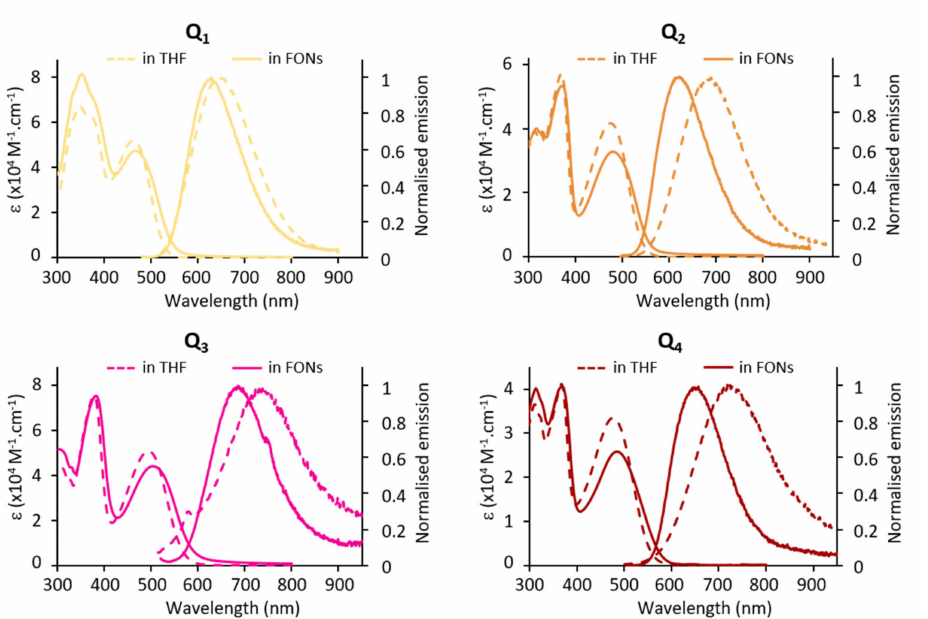
Figure 7. Absorption and emission of dyes in THF vs. FONs: confinement effects. The fluorescence emission spectra of FONs are blue-shifted with respect to the dyes dissolved in THF (Figure 7) but red shifted compared to in toluene. The Stokes shift values indicate an environment of medium-low equivalent polarity (apparent ∆ f = 0.15, 0.10, 0.12, 0.11 for Q 1 , Q 2 Q 3 and Q 4 , respectively) . Interestingly, FONs made from dye Q 1 having the weaker electron-donating end-groups was found to have a similar emission, even slightly red-shifted, and a larger fluorescence quantum yield than FONs made from dye Q 2 . Oppositely, dye Q 3 having the strongest electron-donating end-groups shows the most red-shifted emission and the weakest fluorescence quantum yield. The main observation is the marked reduction in fluorescence upon confinement within FONs. In addition,